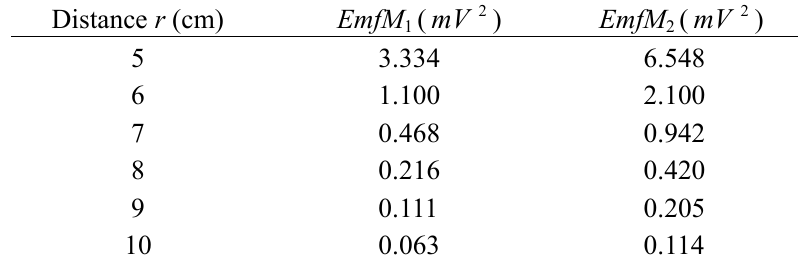
Table 3. The power Emf signal produced by a sensor module in the linear movement experiment.